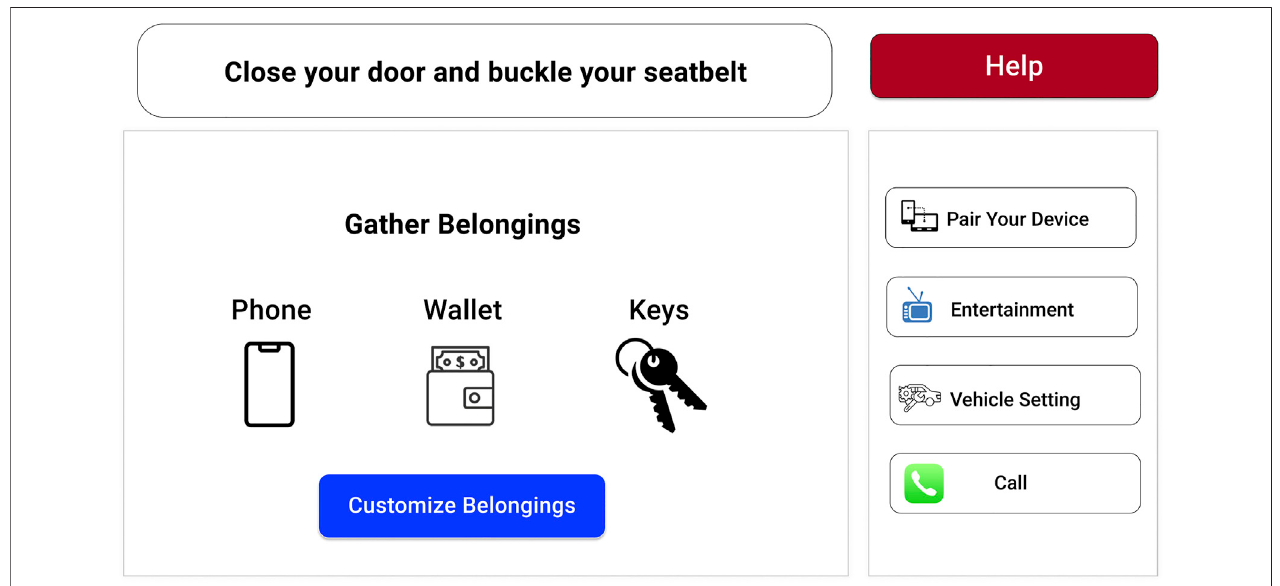
FIGURE 3 | Prototype of users ’ safety steps and belongings checking